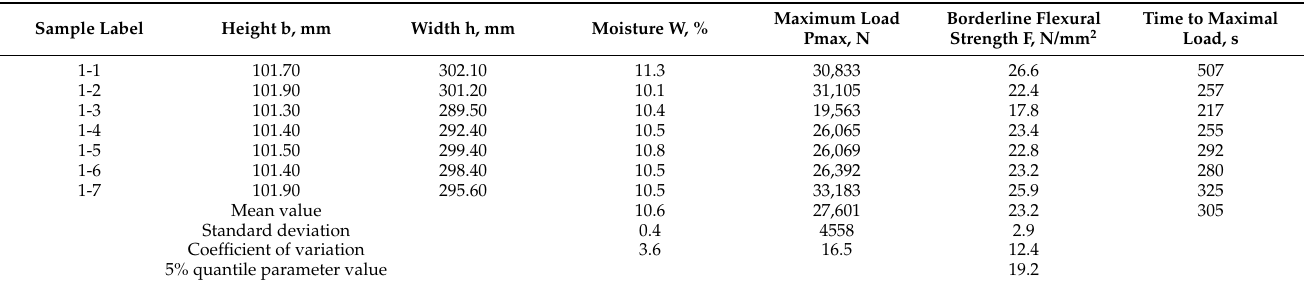
Table 1. Characteristic values of borderline flexural strength, group 1 (load applied on the widest face). Sample